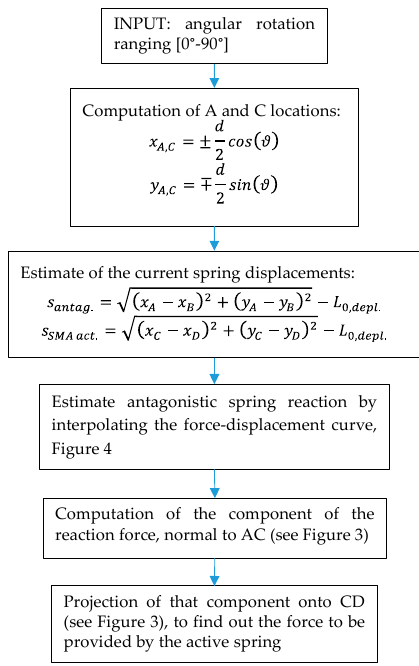
Estimate antagonistic spring reaction by interpolating the force-displacement curve, Figure 4 Computation of the component of the reaction force, normal to AC (see Figure 3) Projection of that component onto CD (see Figure 3), to find out the force to be provided by the active spring Figure 6. Flowchart used for the estimate of the equilibrium configuration of the system. Each angular rotation, ϑ , is, in fact, related to the spring length ( i.e. , the distances of A and C from B and D, respectively). For the bias spring AB it is thus possible to compute the elastic reaction